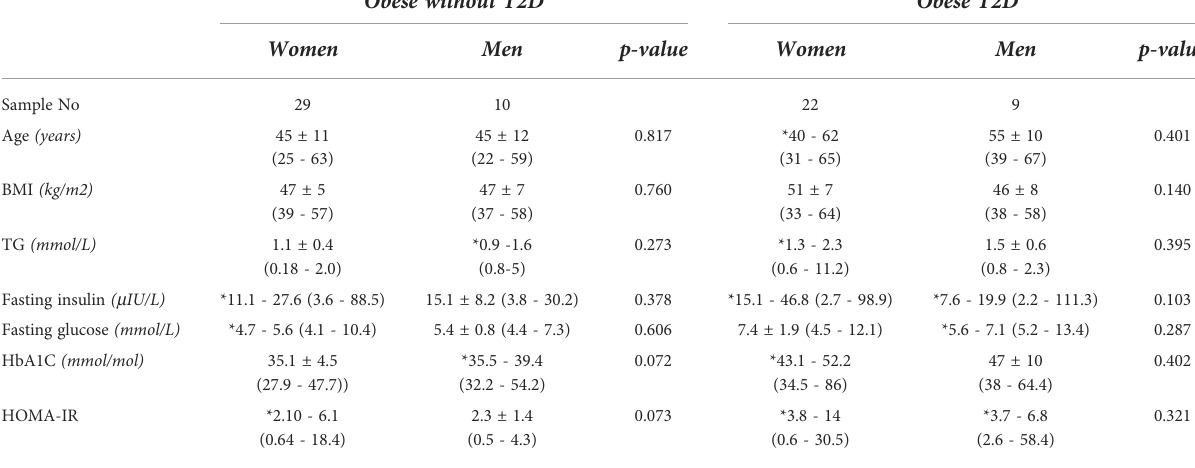
TABLE 2 Clinical parameters of cohort